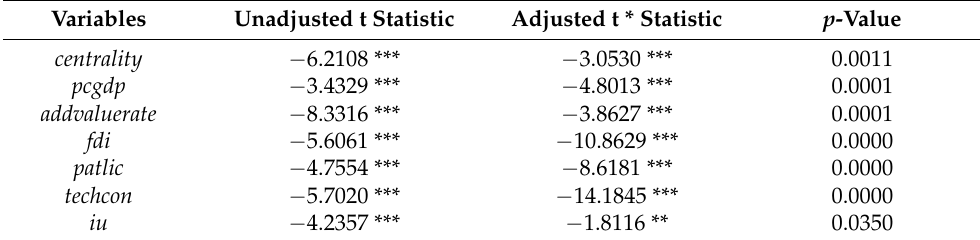
Table 2. LLC unit root test.